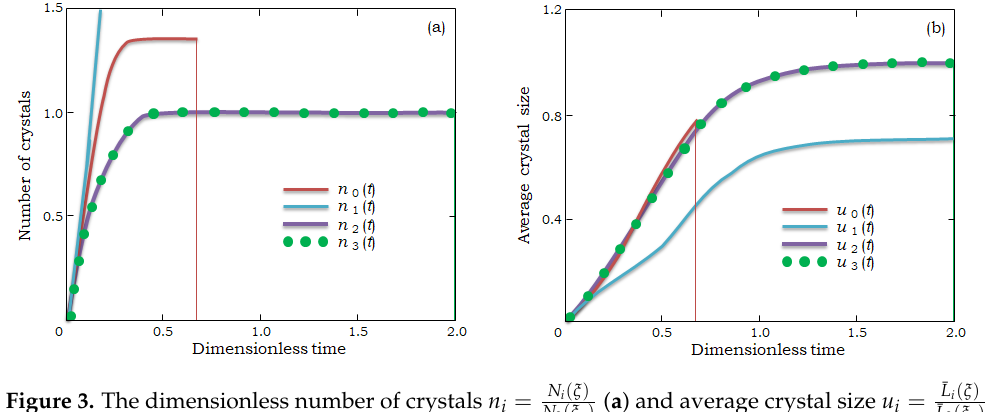
Figure 2. The dimensionless distribution function Φ ( t , ζ ) as a function of ζ = r t = τ for supercooled melts with WVFZ kinetics: ( a ) p = 669, ∆ T 0 = 373 K, (1) t = 0.05, ξ = 0.05, τ 0 (2) t = 0.254, ξ = 0.25, (3) t = 0.503, ξ = 0.45, and (4) t = 1.513, ξ = 0.591; ( b ) p = 7.4, ∆ T 0 = 573 K, (1) t = 0.051, ξ = 0.05, (2) t = 0.263, ξ = 0.25, (3) t = 0.496, ξ = 0.45, and (4) t = 1.95, ξ = 0.71. The maximal size ζ m of crystals is shown by vertical lines at different moments of time. The curves denoted by simbole (4) corresponding to the moment when supercooling is removed ( υ = 0).